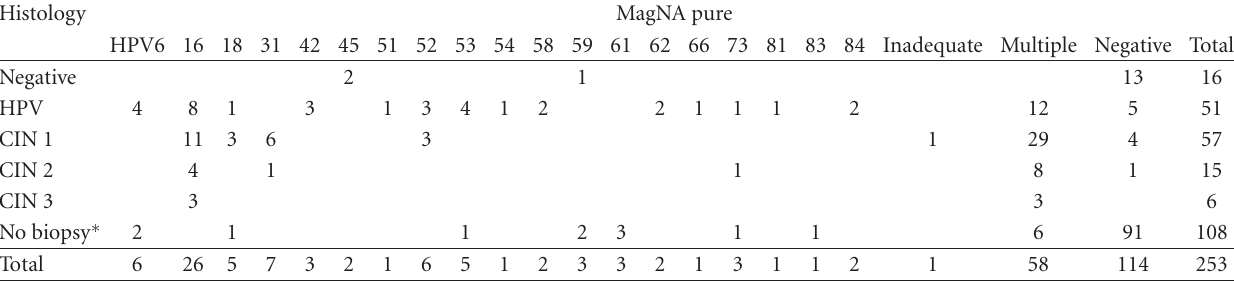
Table 8: Distribution of HPV types (in single infections) detected by MagNA Pure method against Histological Diagnosis. Histology MagNA